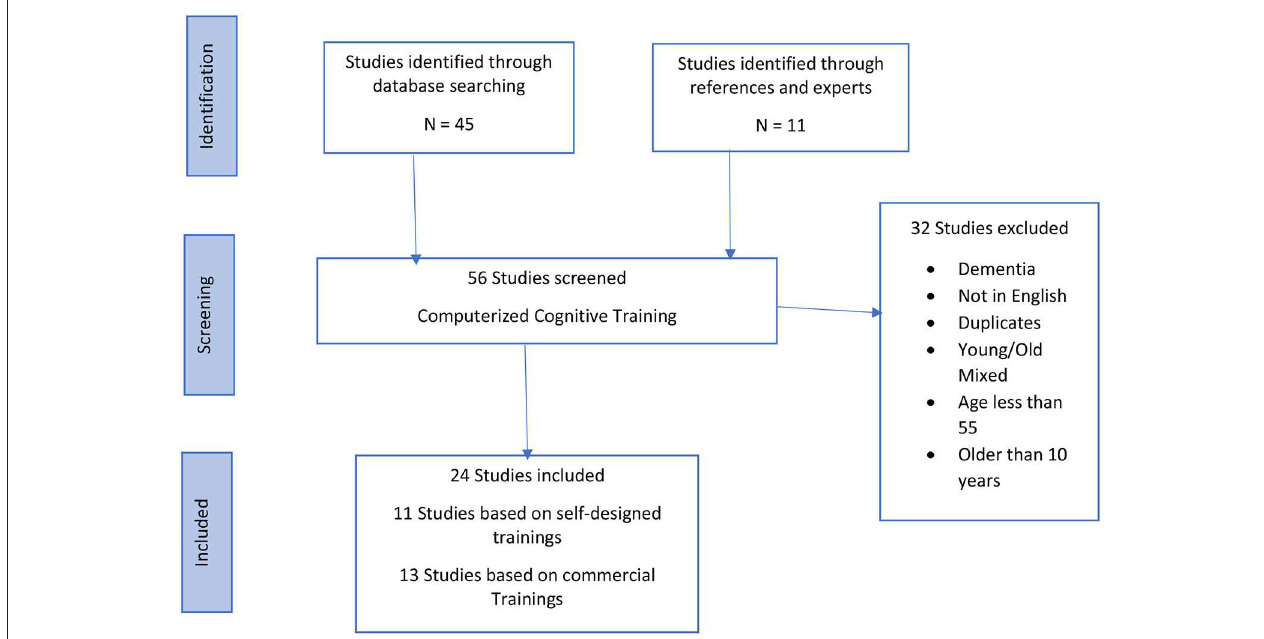
FIGURE 1 | Computerized Cognitive Training (CCT)—flow diagram of search results.